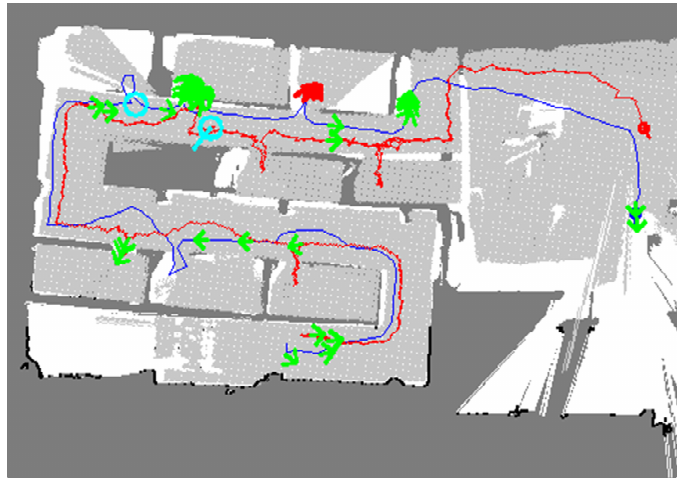
Figure 9. Map merging result without the TSD grid update; the two maps were imperfectly merged.